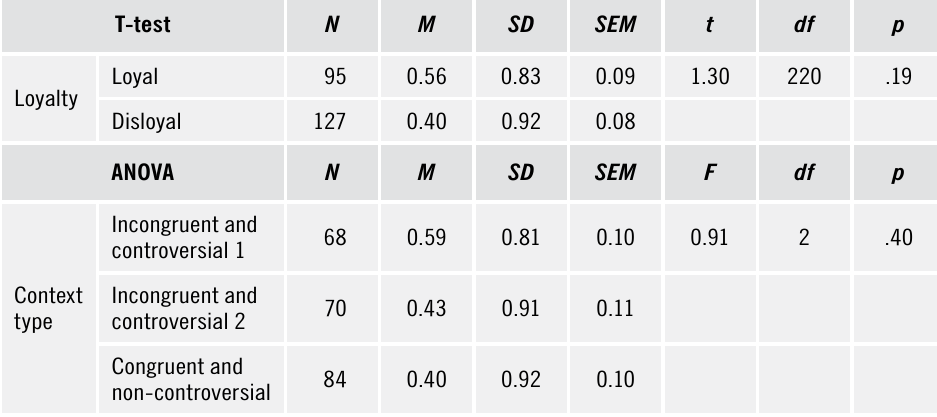
Table 2. Change in sponsorship-vignette awareness by independent variables T-test N M